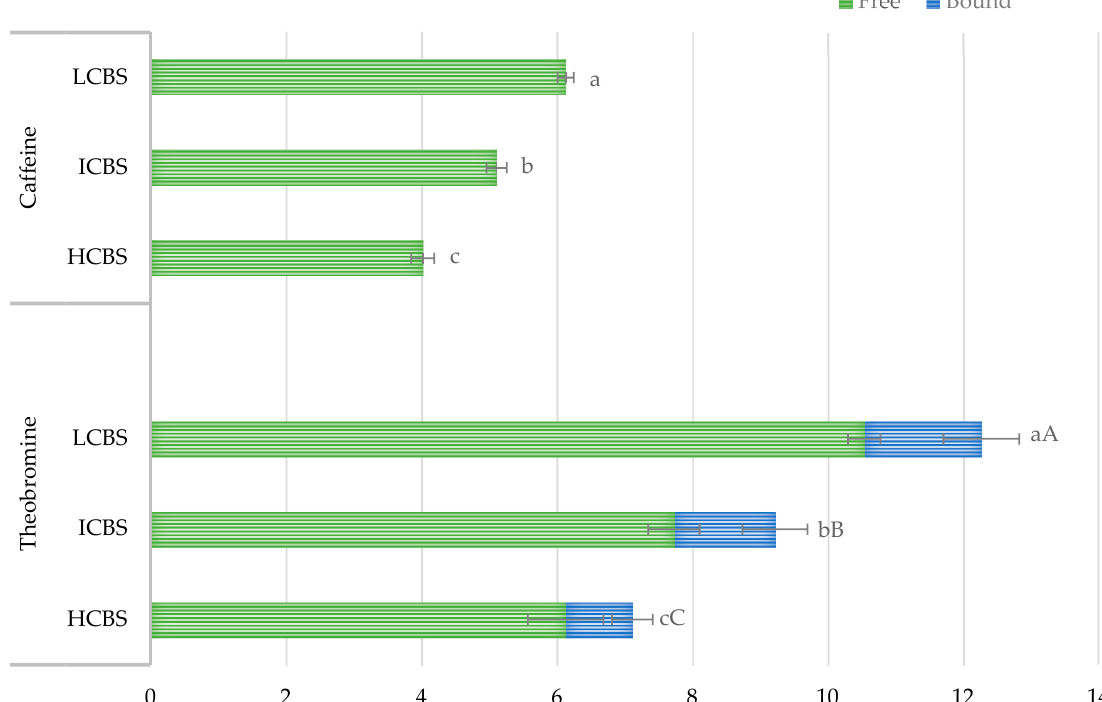
Figure 2. Effect of particle size on Methylxanthines content (Theobromine and caffeine) of cocoa bean shell flours. Values expressed as mg/g sample. HCBS: highest cocoa bean shell (Dp > 701 µ m); ICBS: intermediate cocoa bean shell (417 µ m < Dp < 701 µ m); LCBS: lowest cocoa bean shell (Dp < 417 µ m). For each free compound, bars followed by the same small letter are not significantly different ( p > 0.05) according to Tukey’s Multiple Range Test. For each bound compound, bars followed by the same capital letter are not significantly different ( p > 0.05) according to Tukey’s Multiple Range Test.